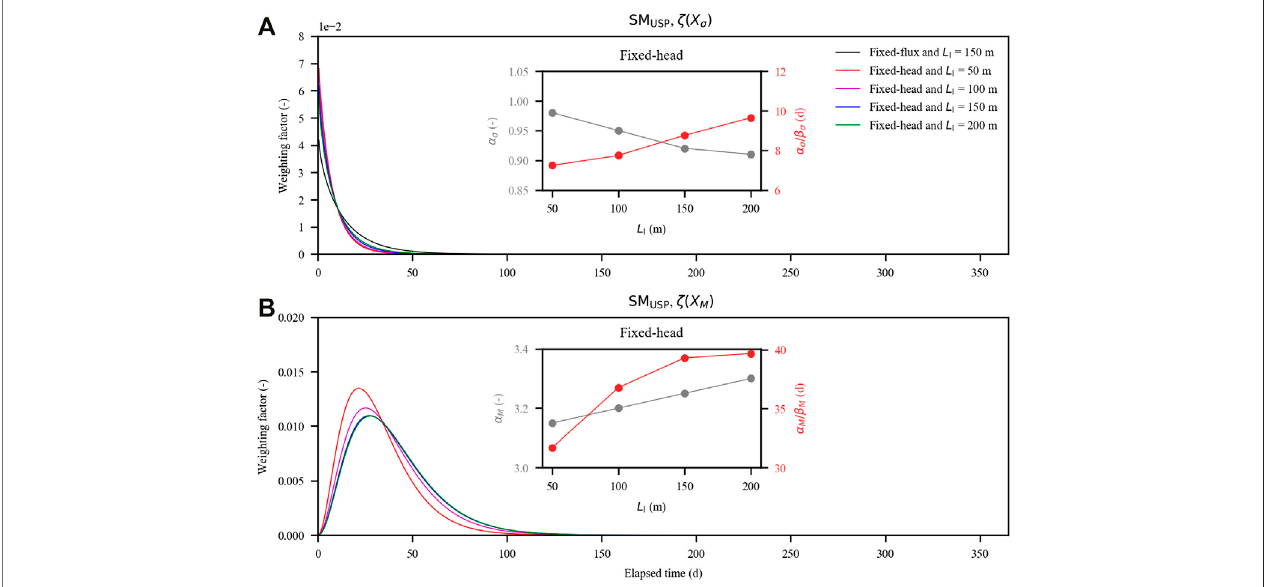
FIGURE 10 | Probability density functions of the amount of salt stored in the upper saline plume (SM USP ) quanti fi ed with the antecedent tidal conditions on the aquifer: (A) time-dependent weighting factor forthe standard deviation oftidal level ( X σ )and (B) time-dependent weighting factor forthe averaged tidal level( X M ).Forthe cases with fi xed-head inland boundaries, the shape and mean parameters ( α and α / β ) of the Gamma distribution functions are given in the inserts.